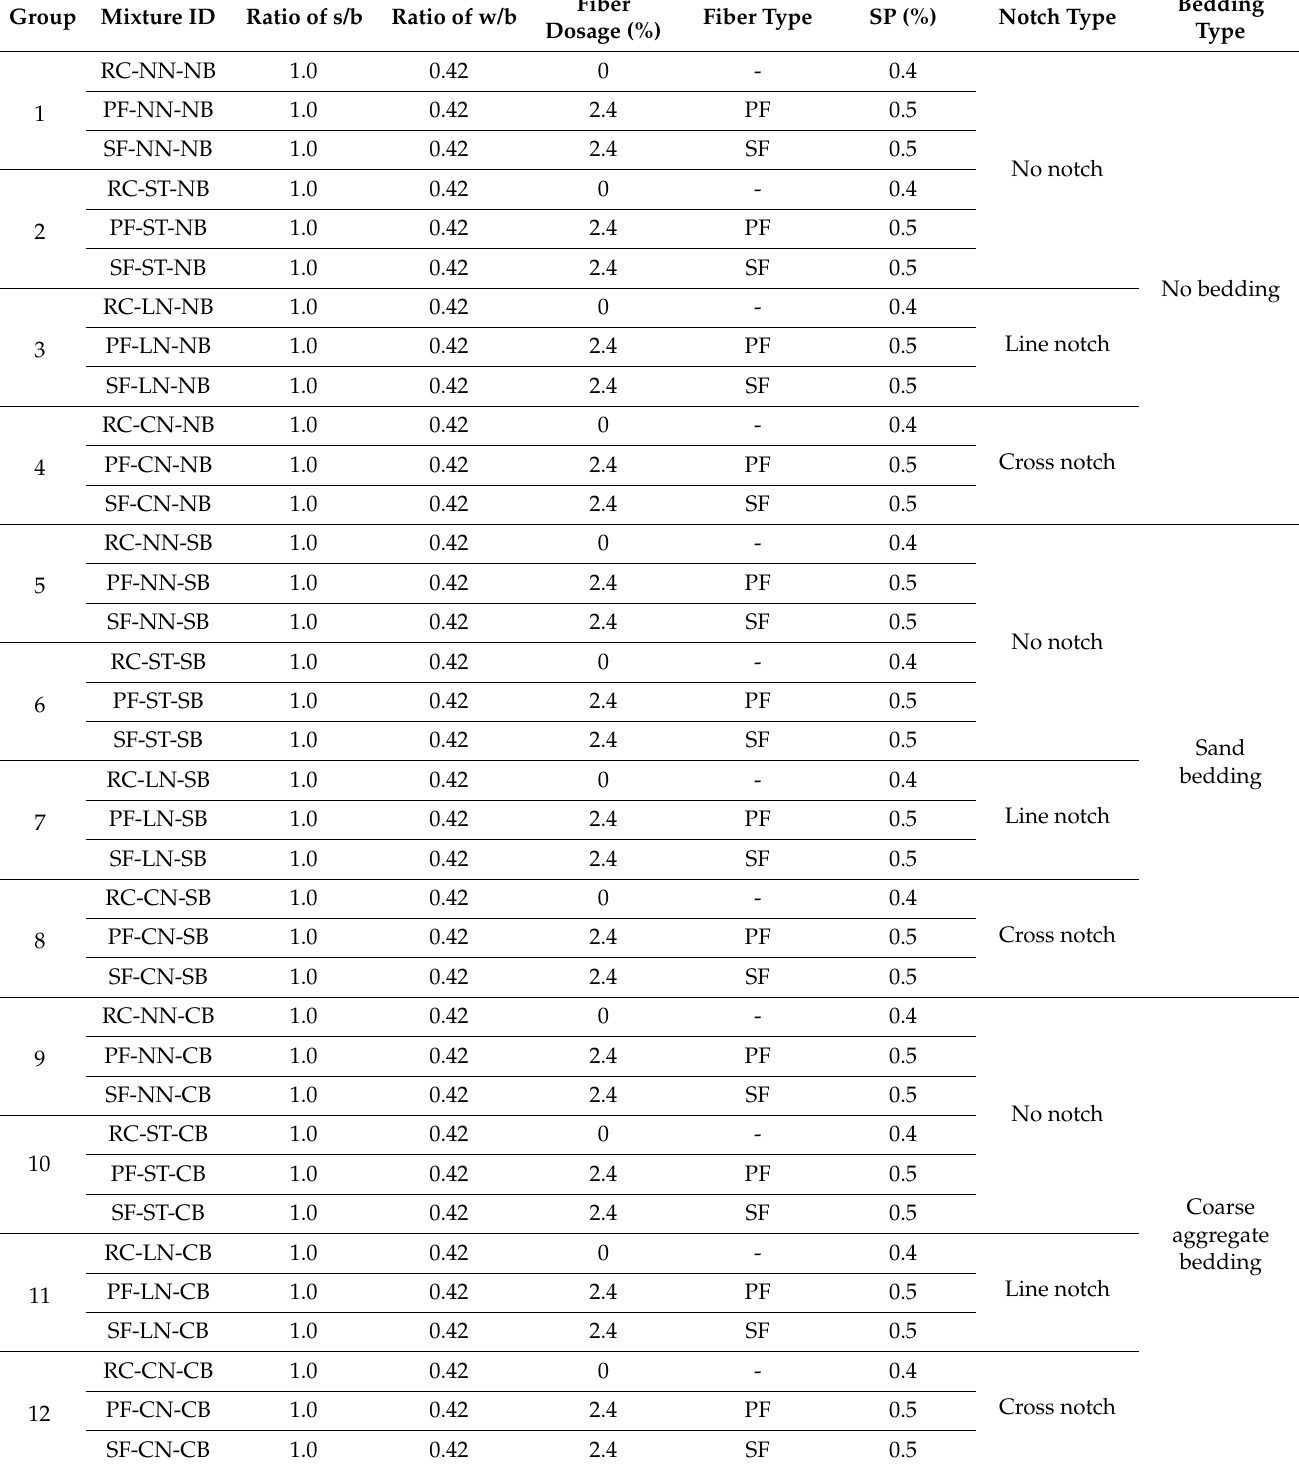
Table 2. Mixing combination, notch, and bedding